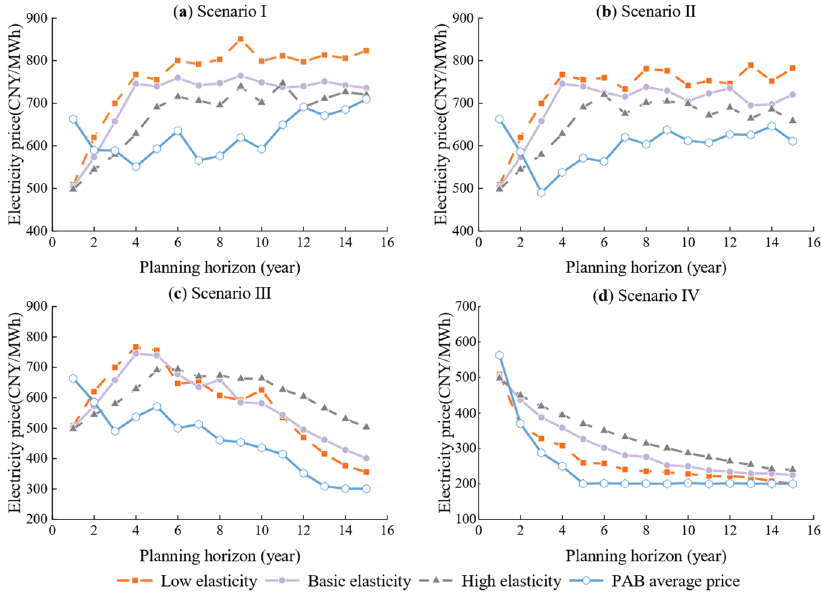
Figure 4. Evolution results of electricity price under the PAB mechanism and supply–demand adjustment